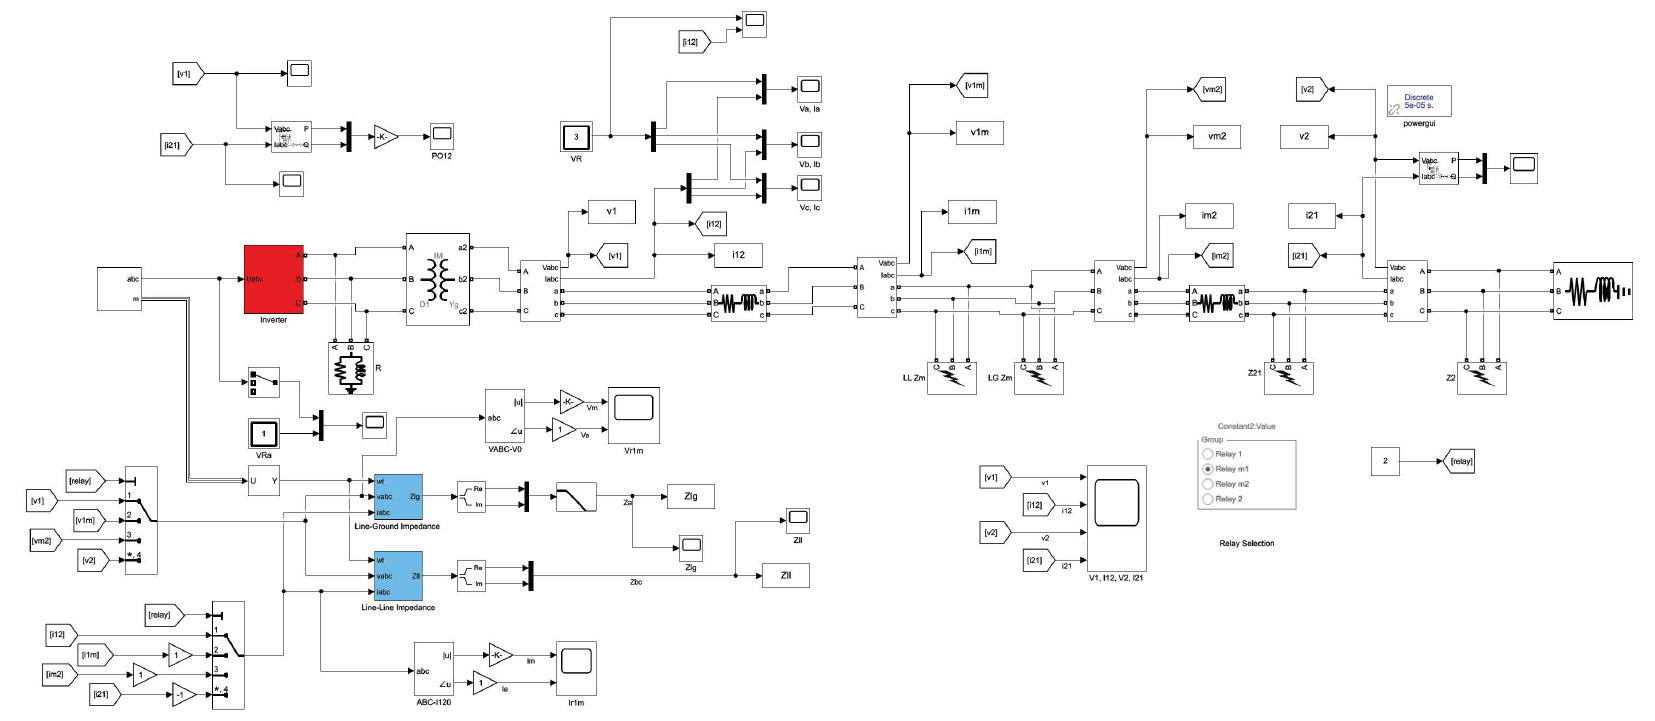
Figure 13. Transient microgrid